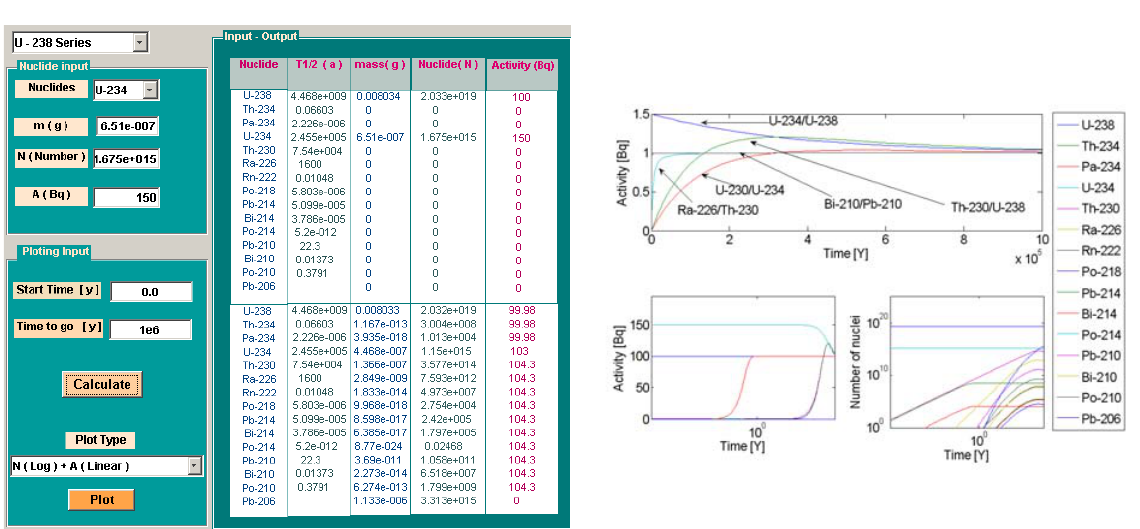
Fig. 5 Exploration of the 238 U decay chain when decay starts with 238 U and 234 U. Initial activities are 100 Bq and 150 Bq, respectively. Decay time is one million years. initial conditions for both parent ( 232 Th) and daughter ( 228 Th) isotopes.